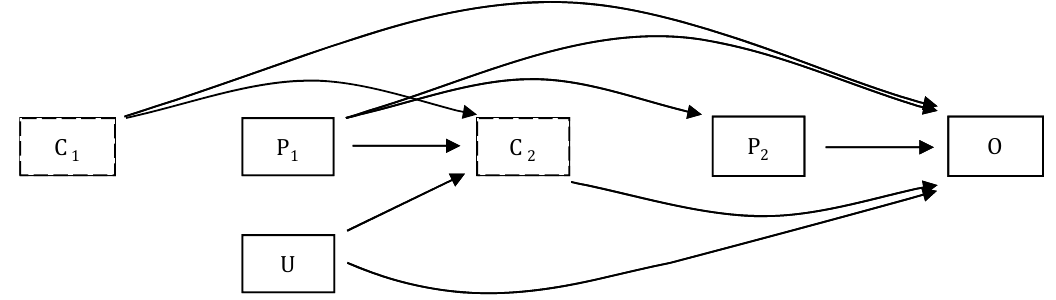
Figure 2 . Propensity Score Weighted Pathways Linking Exposure to Poverty to Child Educational Attainment Note : P = exposure to poverty, C = age‐varying covariates, O = child educational attainment, and U = unobserved factors.